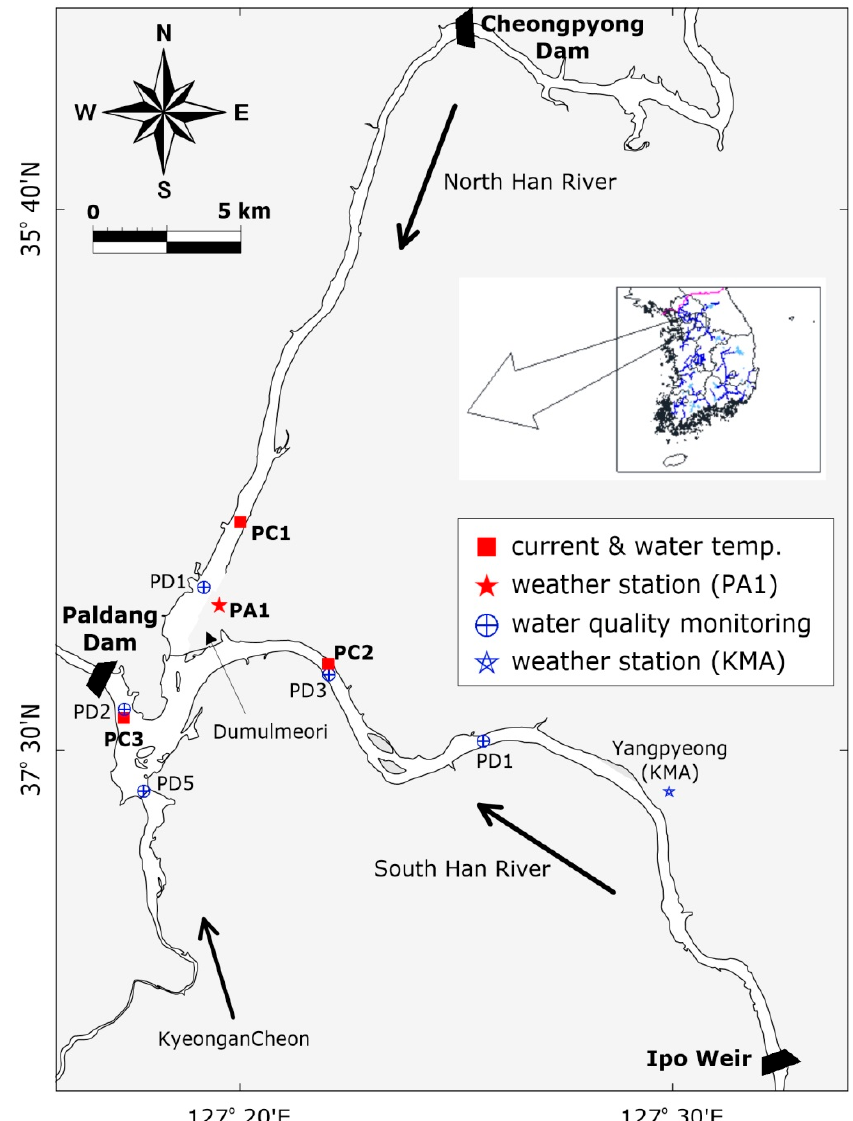
Figure 1. Location of monitoring sites in the Paldang Reservoir.